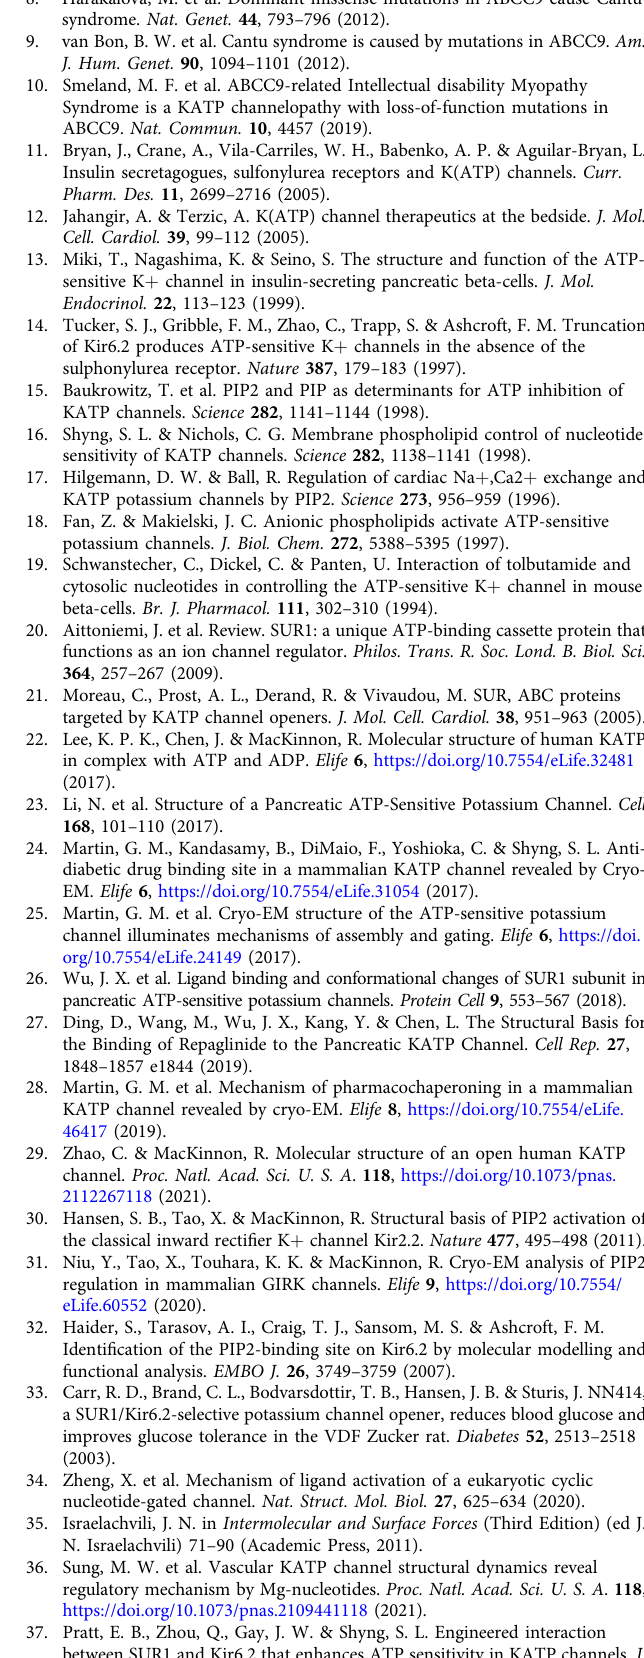
Figure preparation . Figures were prepared using the programs UCSF Chimera X-0.91 (http://www.rbvi.ucsf.edu/chimerax/54) 49 , UCSF Chimera-1.14